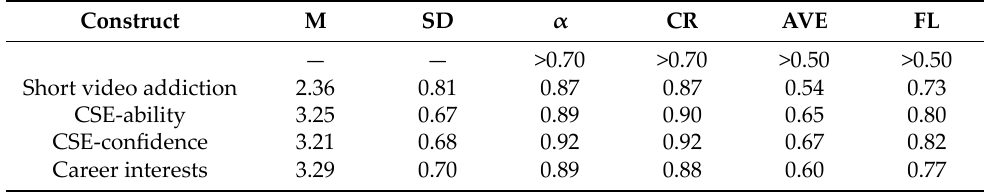
Table 2. Reliability and validity analysis.